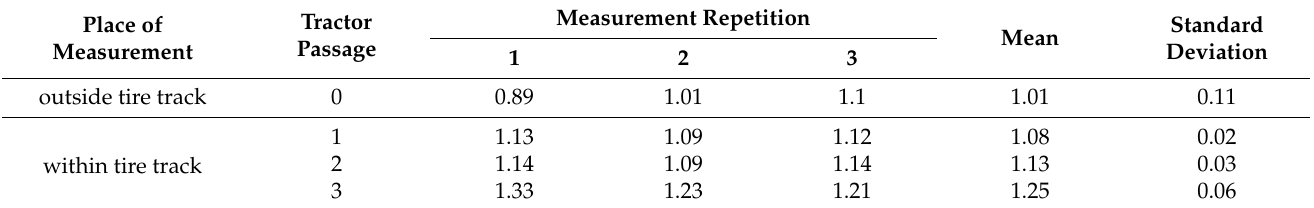
Table 2. Data on soil bulk density (g · cm − 3